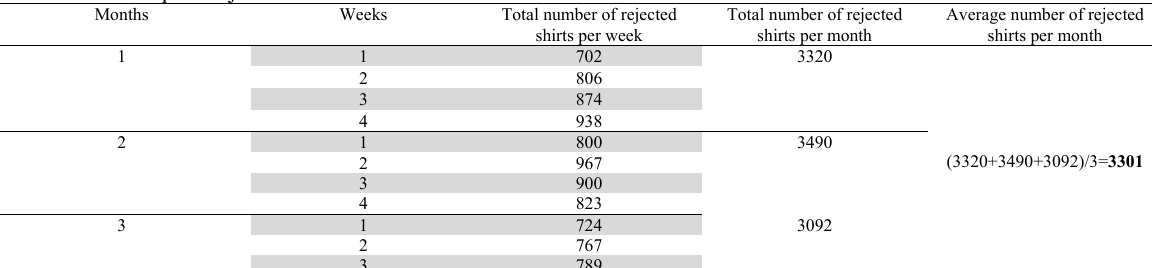
Table 1 shows the three-month defect data with a total of 15 defect types with respective weekly defect amounts. Table 2 Total number of exports rejected shirts 4 Months Weeks Total number of rejected